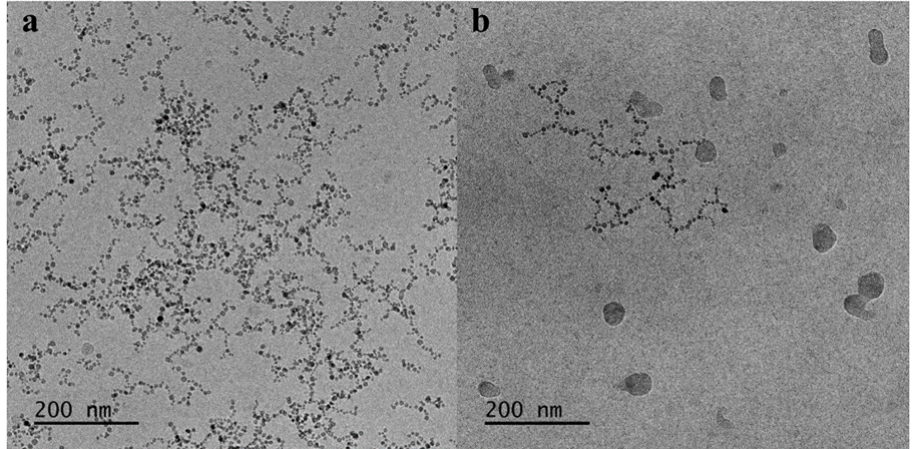
Figure 11. Cryo-TEM micrographs ( a , b ) of the magnetopolyplexes at N / P = 7.